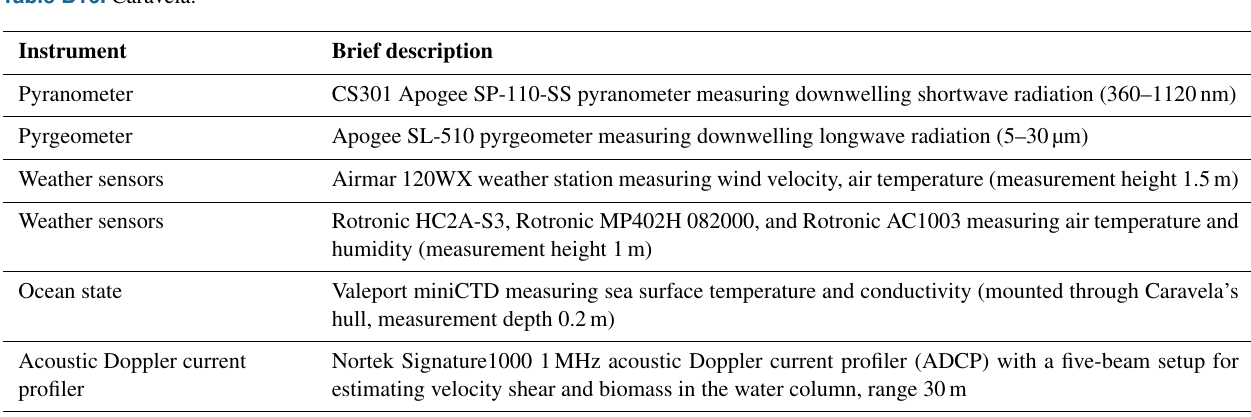
Table B16. Caravela.